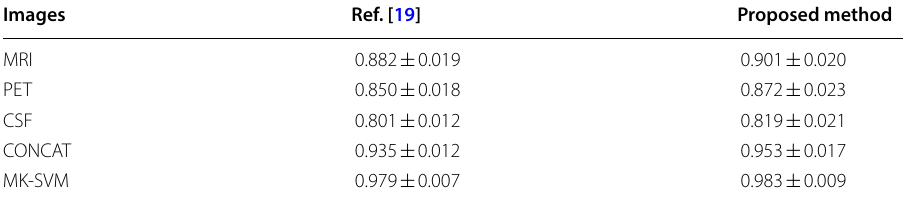
Table 4 The average accuracy of the methods in the AD and HC classification Images Ref. [19]